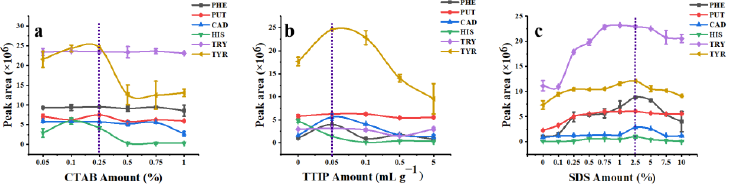
Figure 4. Optimization of MCM − T − H synthesis, ( a ) the amount of CTAB; ( b ) the amount of TTIP; ( c ) the amount of SDS.